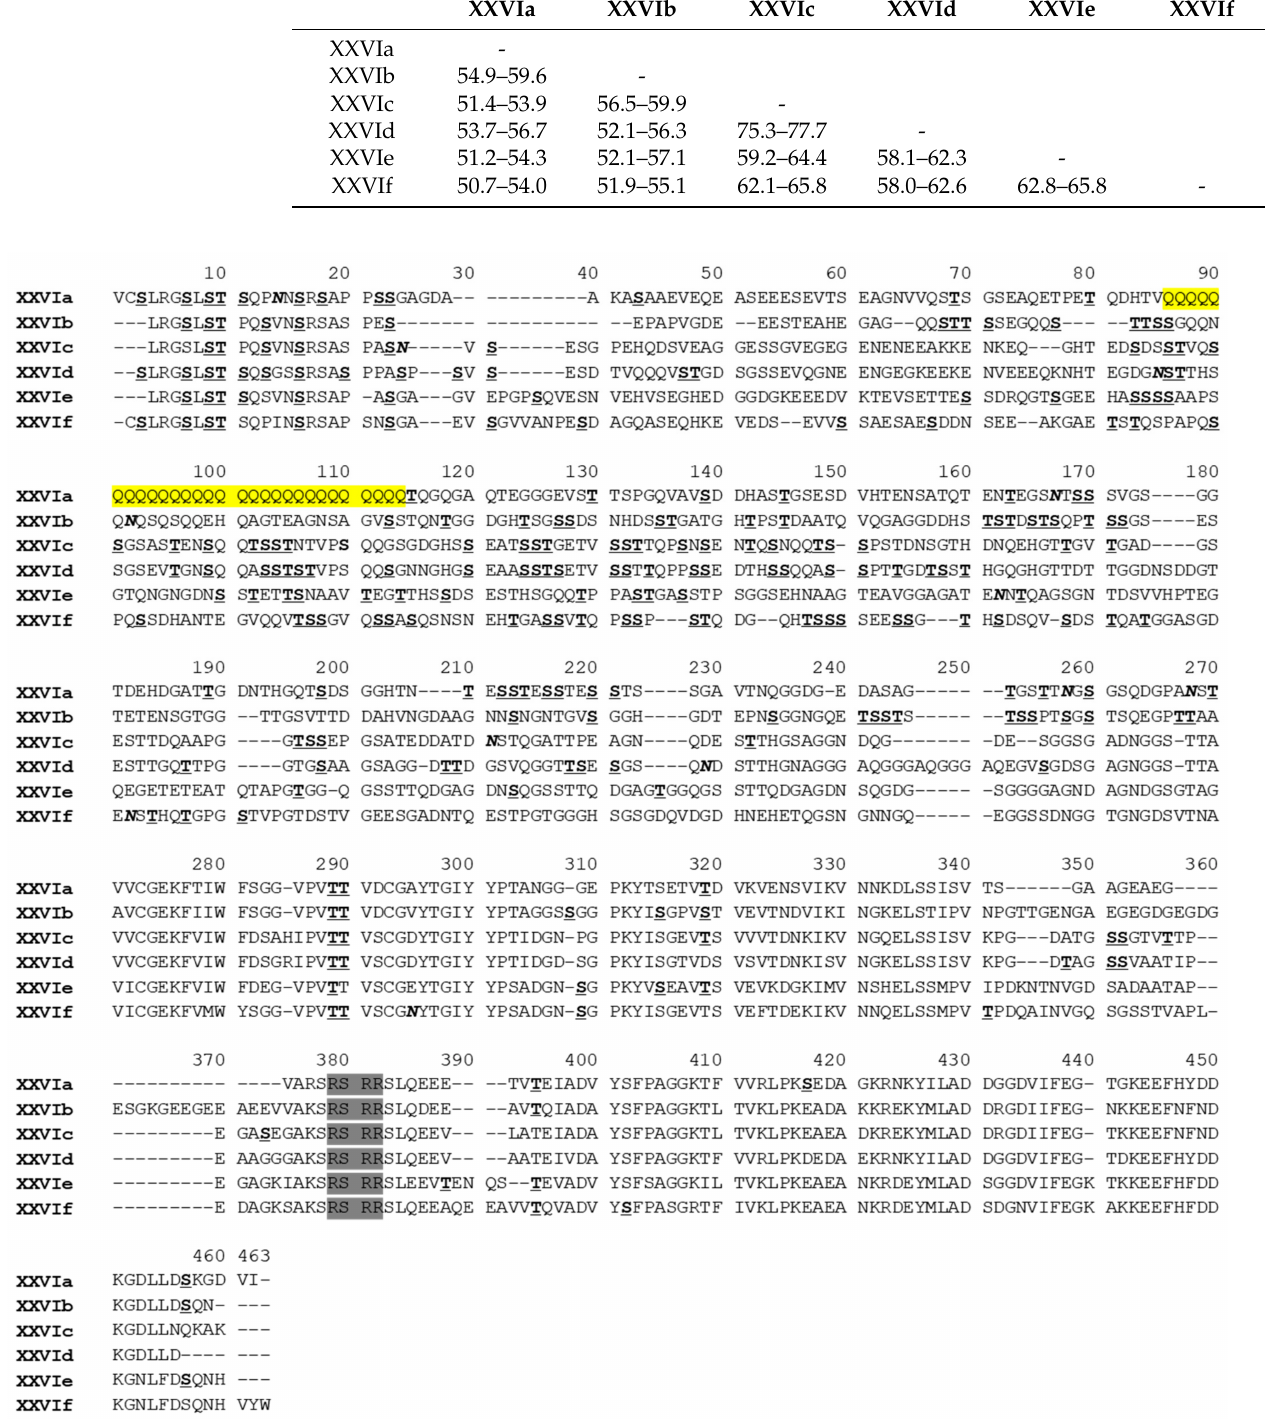
Figure 3. Alignment of partial amino acid sequences of GP60 from six Cryptosporidium bovis subtype families. The putative furin cleavage site is shaded in gray. Potential N-linked glycosylation sites are marked in bold and italics, and O-linked glycosylation sites in bold with underline. The unique polyglutamine tract in XXIVa is highlighted in yellow. Dashes indicate amino acid deletions, except those at the N- and C-termini of the